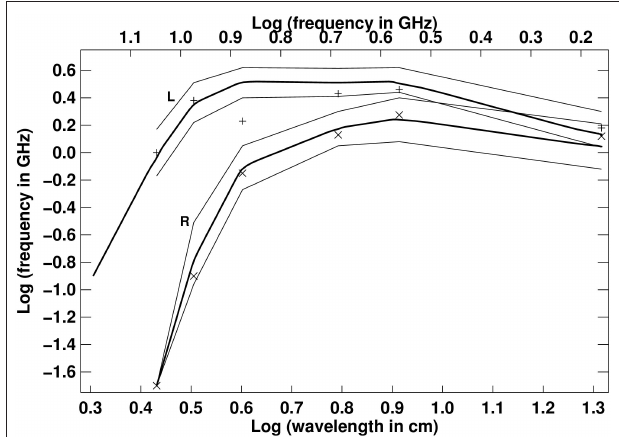
FIGURE 9 | Model flux density spectra in L and R polarizations ( x - and o -mode, respectively), computed from magnetic field extrapolations for the cases: (i) h 0 2,000 km, F c 6 10 6 erg cm − 2 s − 1 , (thick lines), (ii) = = × h 0 2,000 km, F c 3 10 6 erg cm − 2 s − 1 , (iii) h 0 = = × F